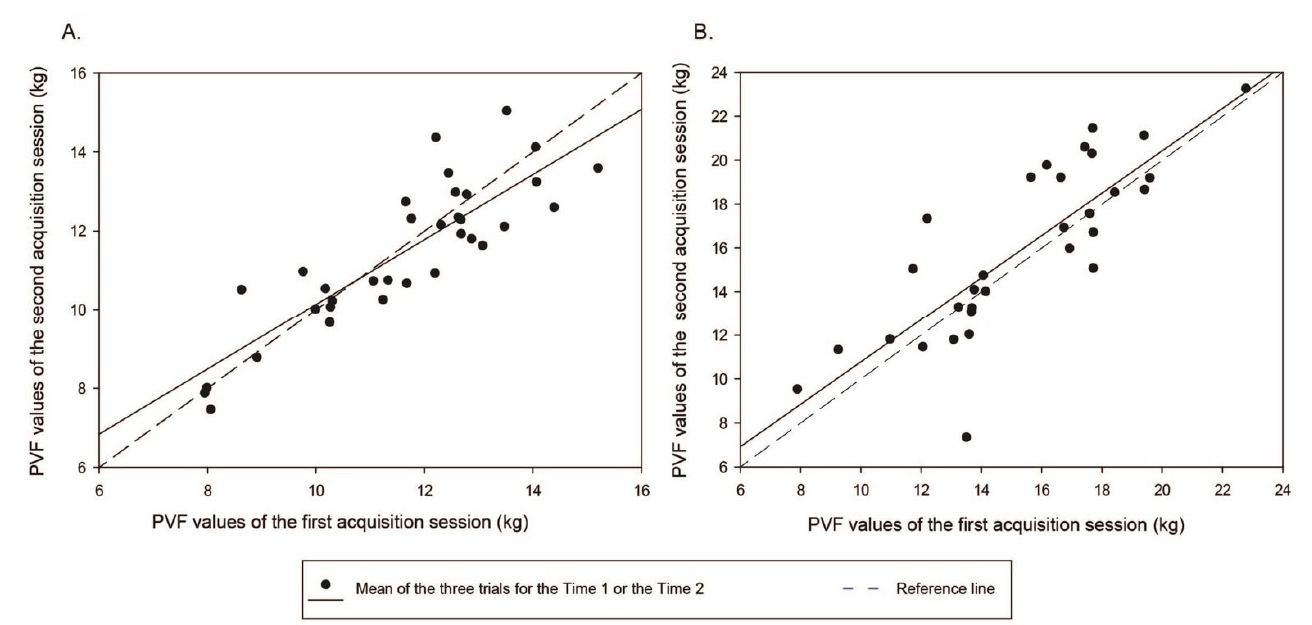
Figure 1. Concordance plot for the PVF values obtained during the first (X axis) and second (Y axis) baseline acquisition sessions for ( A ) the thoracic limbs and ( B ) the pelvic limbs. Each point corresponds to the mean of the three valid trials for one cat. A perfect concordance is reflected by a 45 ◦ slope (dotted line). Table 2. Best normalization process for Effort Path